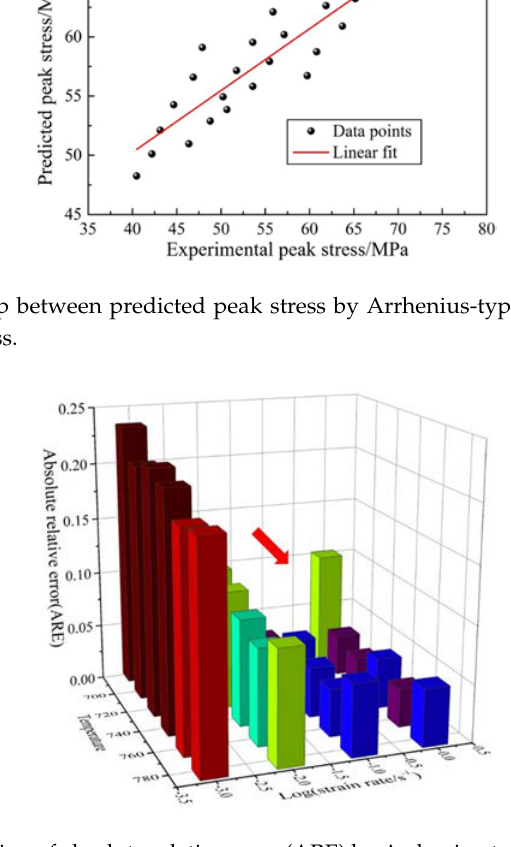
Figure 11. Distribution of absolute relative error (ARE) by Arrhenius-type constitutive model.